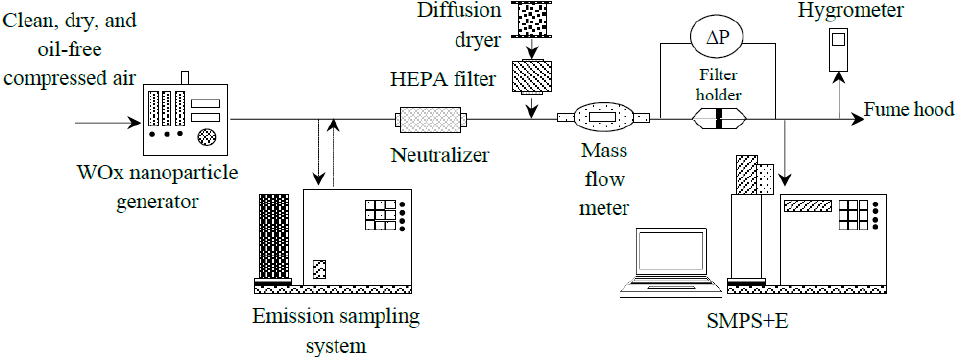
Figure 2. Schematic diagram of the experimental setup.